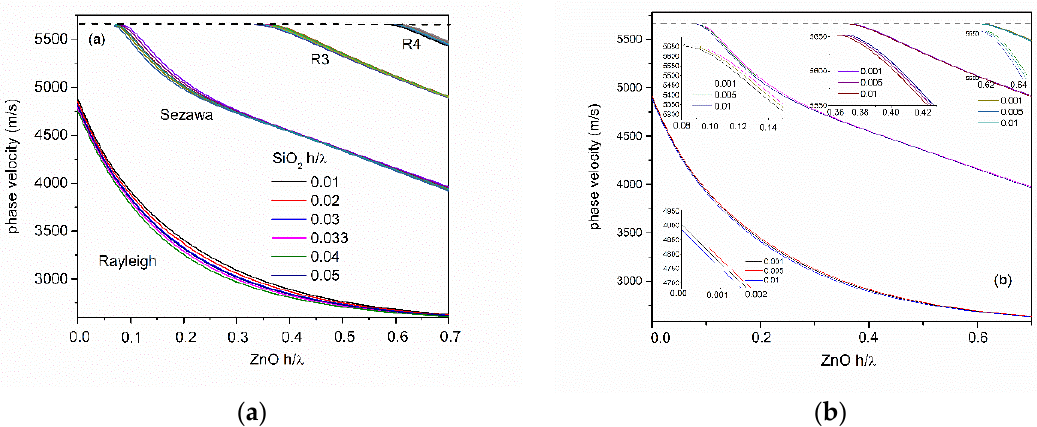
Figure 3. The phase velocity dispersion curves of R m , S m , R3, and R4 modes for SiO 2 thickness-to- wavelength ratio ranging ( a ) from 0.01 to 0.05 and ( b ) from 0.001 to